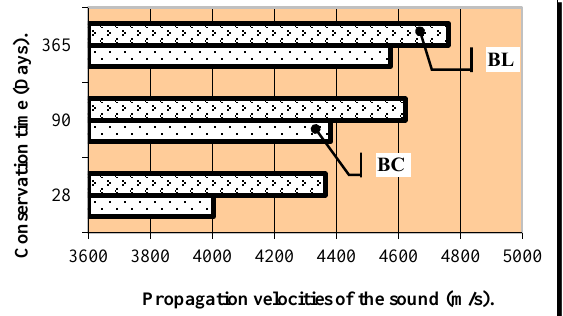
Fig. 9. Evolution of sound propagation velocities through concrete specimens as a function of curing